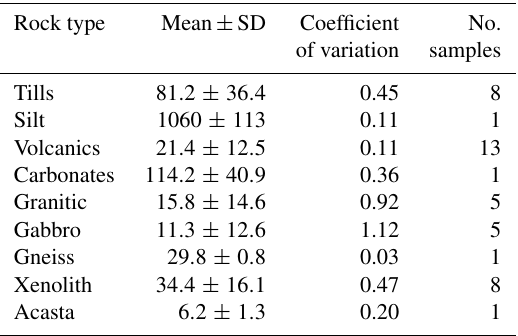
Table 4. Nitrogen concentration (ppm) in upper-crustal rocks using the fluorometry